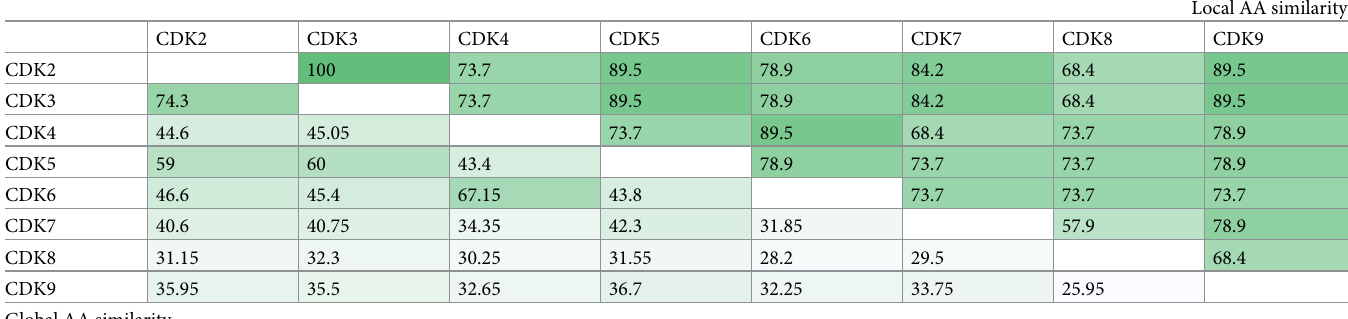
Table 2. Sequence similarity of full-length CDKs (global AA similarity) and the amino acid residues constituting the local structure on CDK9 surrounding 127 (local AA